Question: Write a single sentence explaining what this figure depicts.
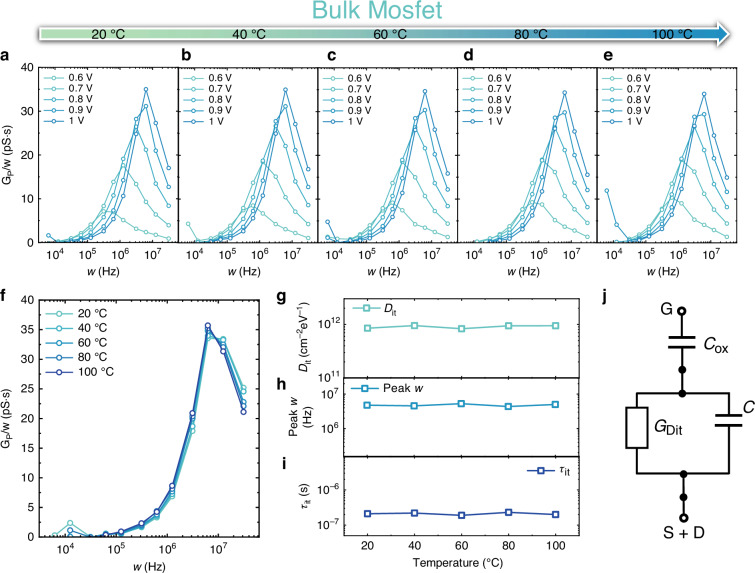
Answer: Temperature-dependent conductance analysis of the bulk MOSFET using the conductance method. a – e G p / ω measured at different V G s for temperatures ranging from 20 to 100 °C. f Comparison of G p / ω at different temperatures, showing similar peak positions and magnitudes. g – i Temperature dependence of the extracted interface trap density D it , peak angular frequency, and effective trap time constant. j Equivalent circuit used for the conductance analysis, consisting of the capacitance C and the interface trap conductance G Dit